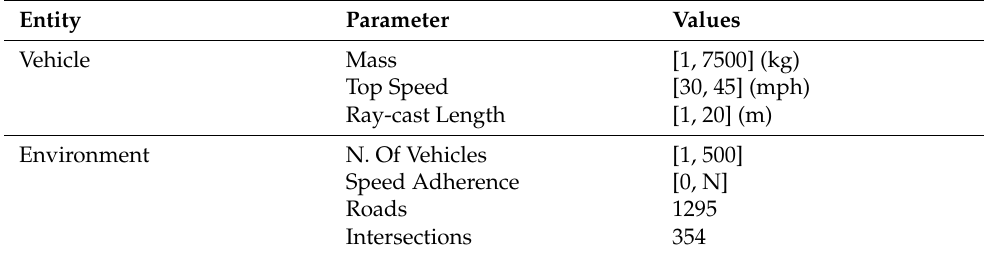
Table 1. Model entities and parameter values, where [X, Y] are a random uniform distribution of values (inclusive)